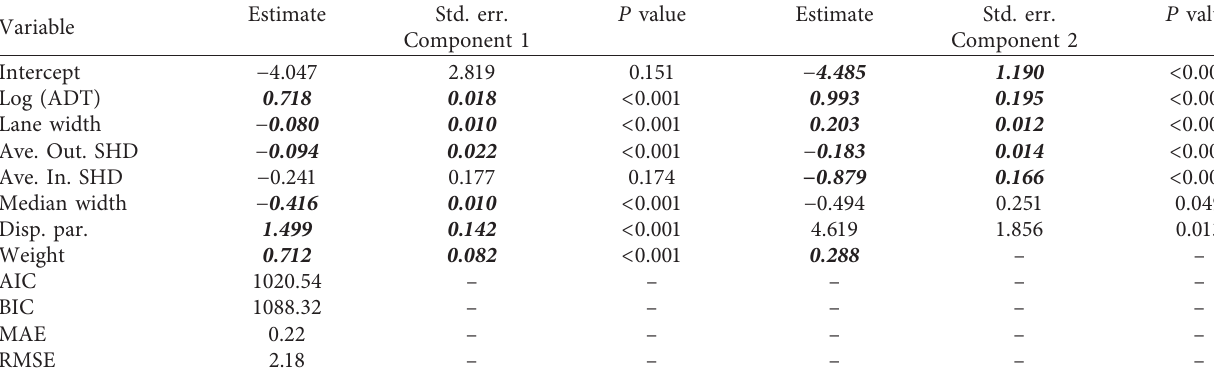
Table 3: Estimating results of the FMZTNB-2 model.